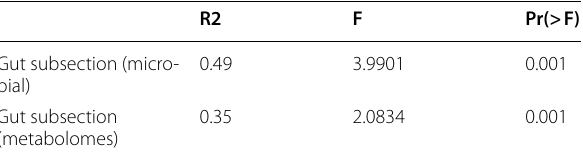
Table 1 PERMANOVA results for microbial communities and metabolomes tested against gut